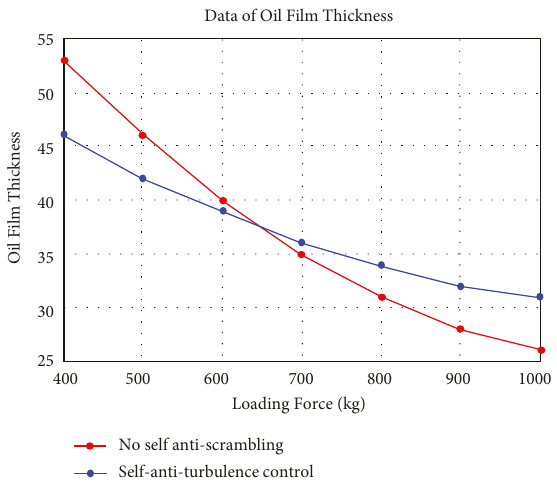
Figure 41: Oil film thickness variation